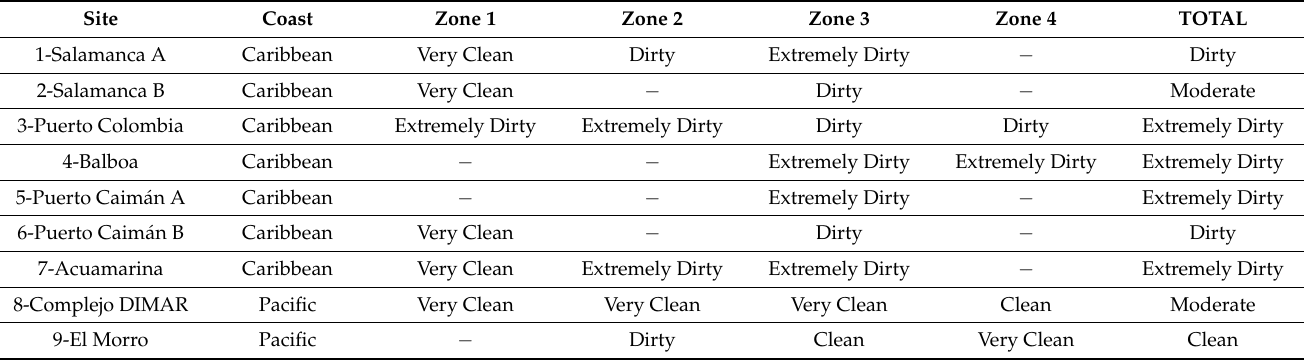
Table 5. Clean Coast Index (CCI) proposed by Alkalay et al.